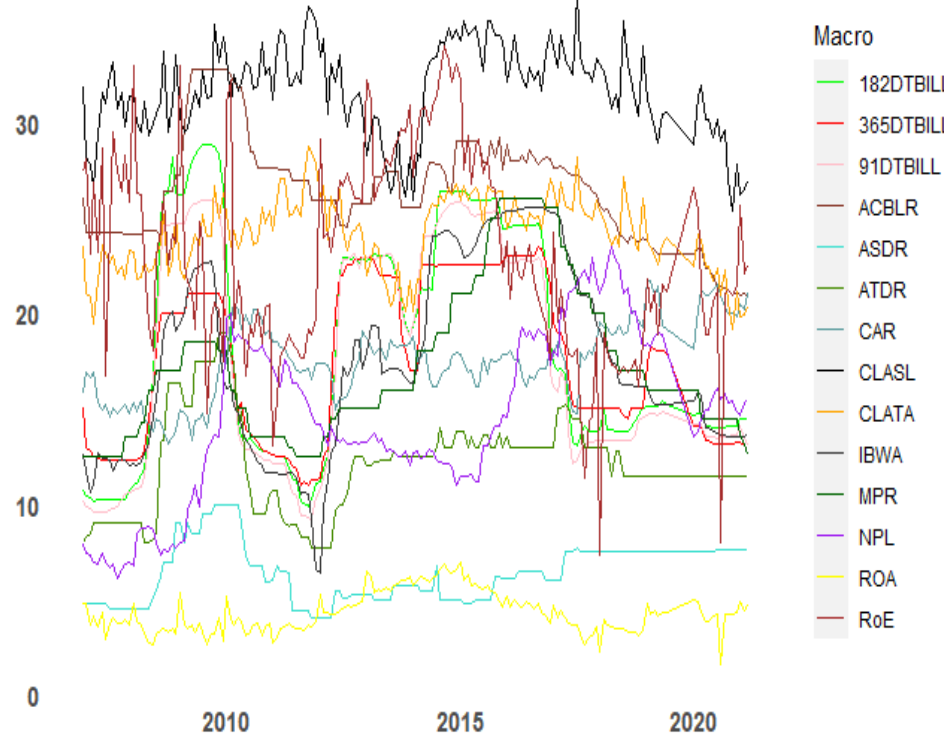
Figure 2. Combined plots of both banking sector financial soundness and interest rate measures from January 2007 to March 2021.